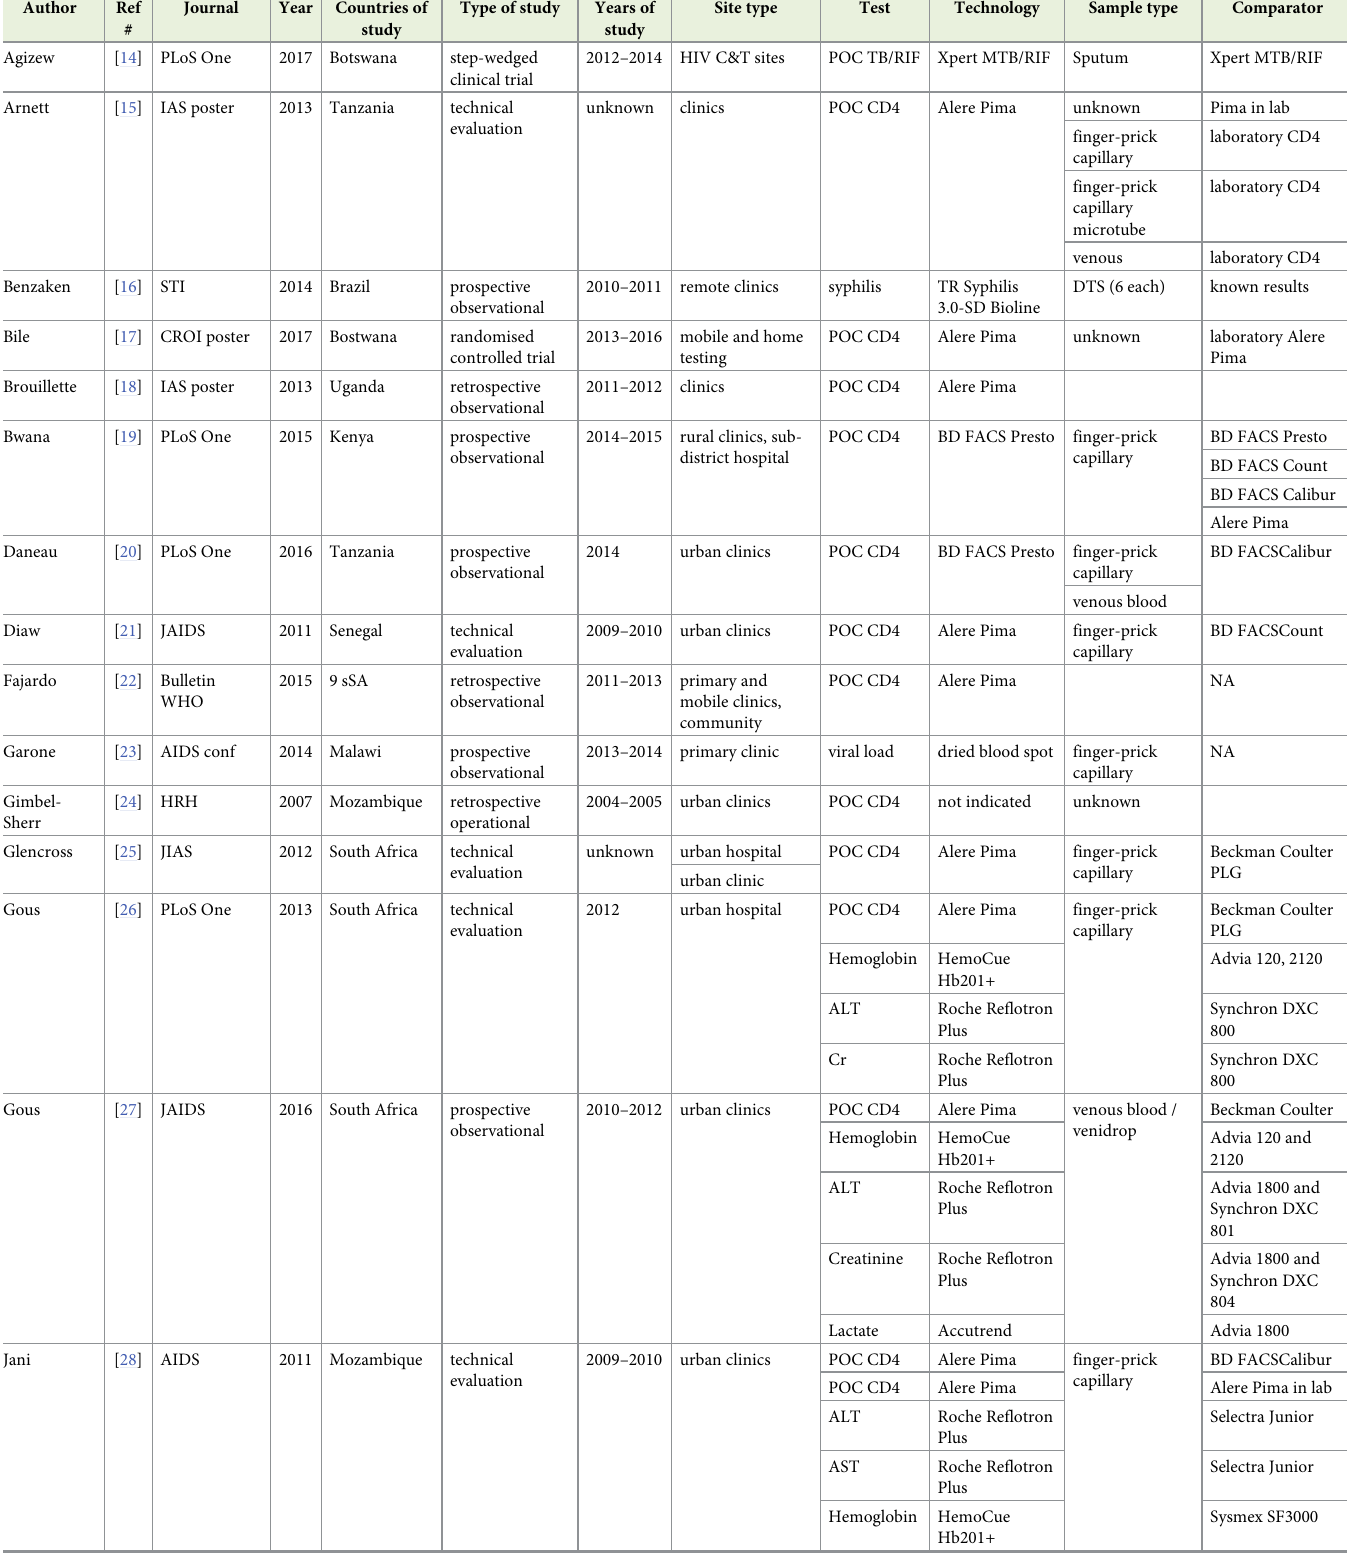
Table 1. Study characteristics of included studies in